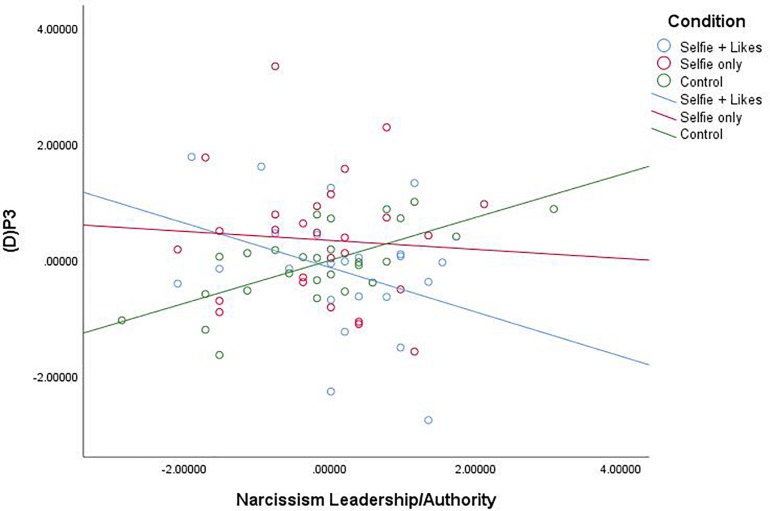
Scatterplot for the interaction between condition and Narcissism—Leadership/Authority (Z score) on white noise P3 mean amplitude change scores (Z score).